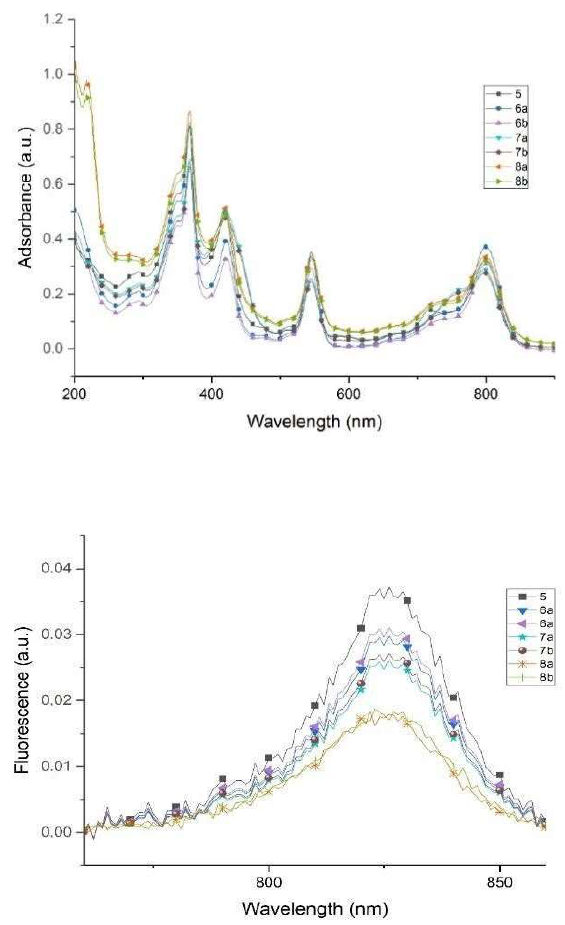
Figure 2. Absorption and electronic fluorescence spectra of dipropoxy-BPI 5; amino acid modifications 6a , b ; NHC-compounds 7a , b and metal complexes 8a , b . The electronic spectra of conjugates 8a and 8b exhibited a strong absorption line in the UV range at 220 nm, characteristic of NHC complexes of gold(I).